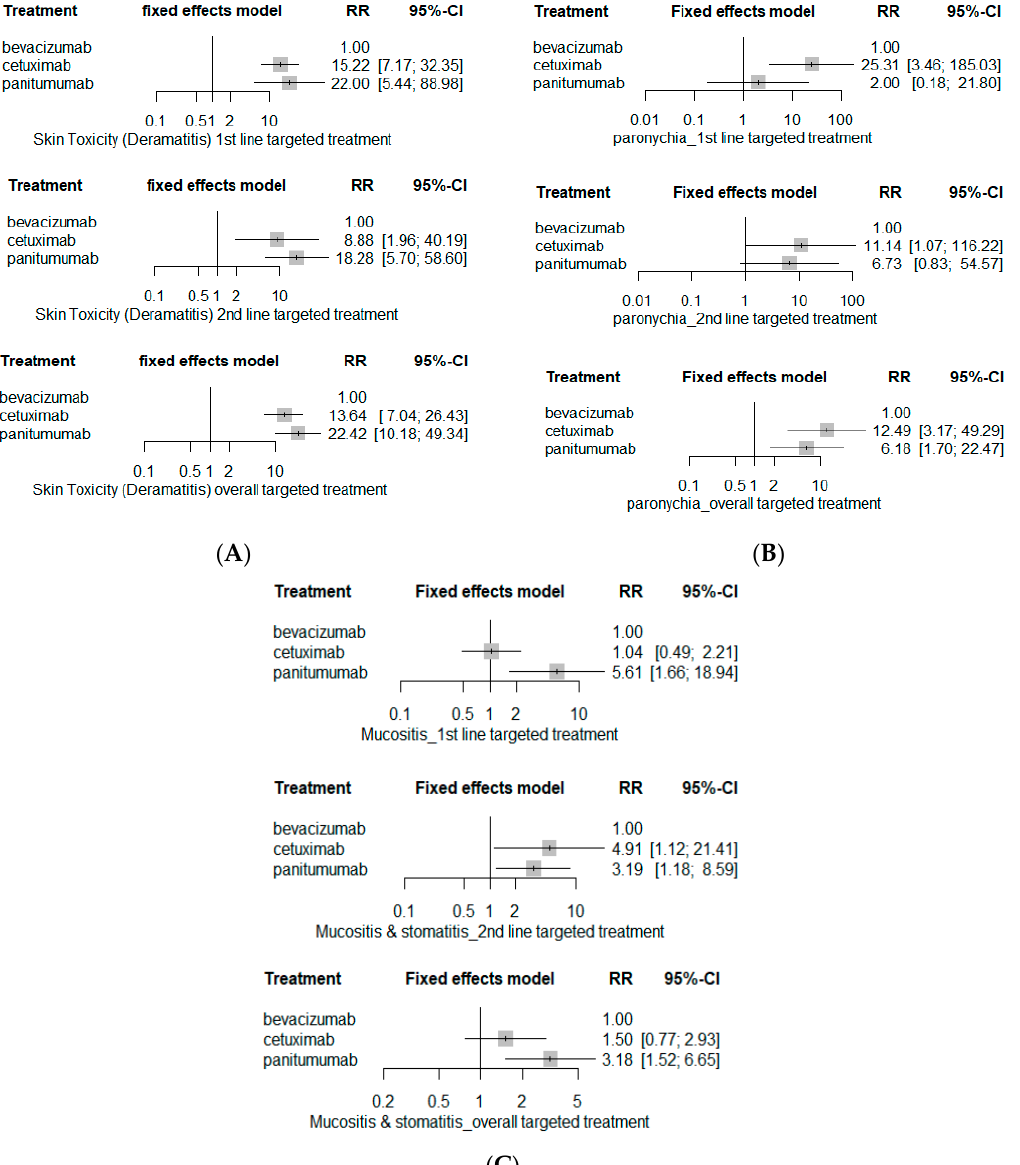
Figure 8. Dermatological SAE risks. ( A ) Rash (skin toxicity); ( B ) paronychia, and ( C ) mucositis. EGFR inhibitors including cetuximab and panitumumab markedly increased SAE risks pertaining to renal systems (Figure 9). Both cetuximab and panitumumab substan- tially elevated the risks of serious electrolyte abnormalities including hypomagnesemia (RR 7.39; 95% CI 2.26–24.20 for cetuximab-based chemotherapy; and RR 20.10; 95% CI 8.92–68.21 for panitumumab-based chemotherapy) and hypokalemia (RR 2.43; 95% CI 1.14–5.18 for cetuximab-based chemotherapy; RR 2.33; 95% 1.21–4.47 for panitumumab- based chemotherapy), whereas risks of serious hypocalcemia and proteinuria were insignif- icant among three targeted agents. The risk of serious dehydration was the highest in patients receiving panitumumab-based chemotherapy (RR 2.81; 95% CI 1.03–7.67).